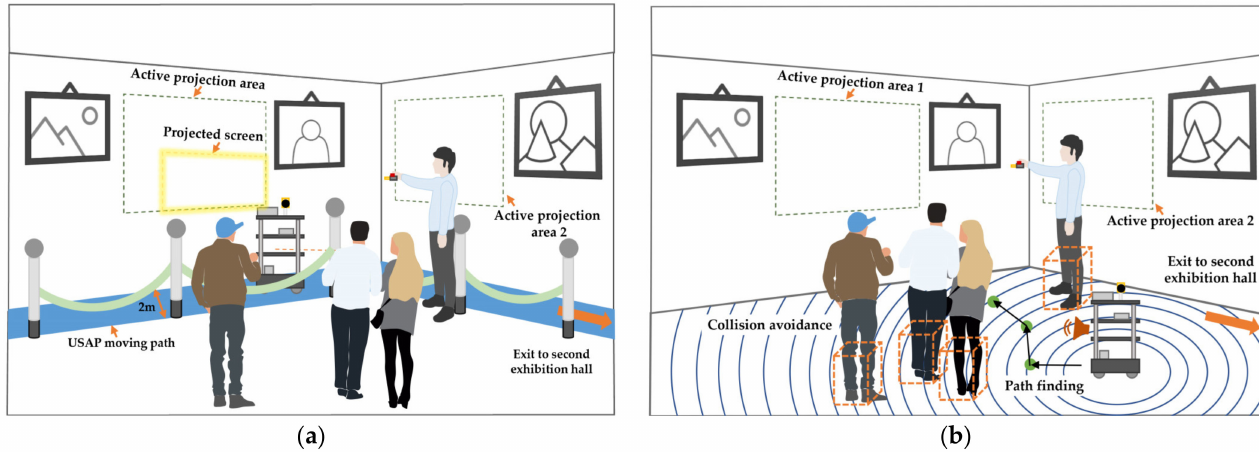
Figure 17. The suggested solutions to navigate safely in a crowded area: ( a ) A physical barrier between the mobile platform and visitors, and ( b ) intelligently avoid the collision and auditory alert for the dangerous